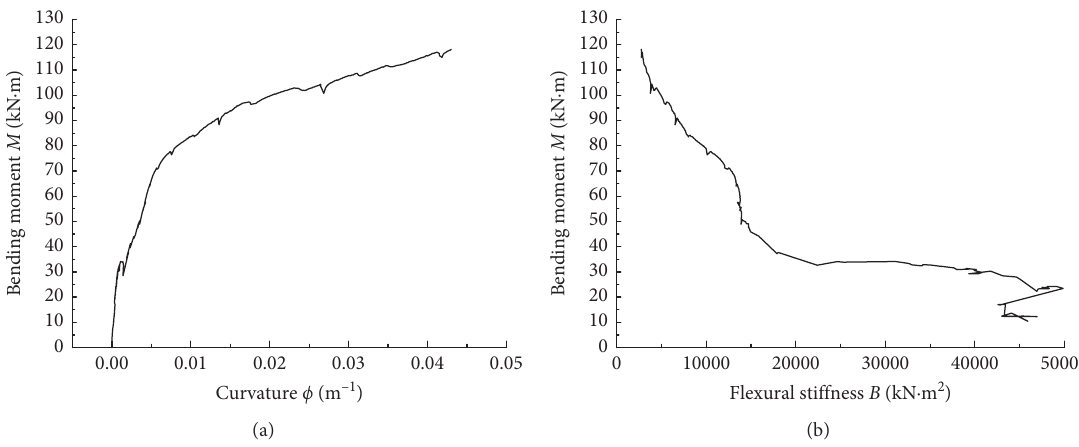
Figure 6: B-2-30-4. (a) Bending moment-curvature curve. (b) Bending moment-stiffness curve.